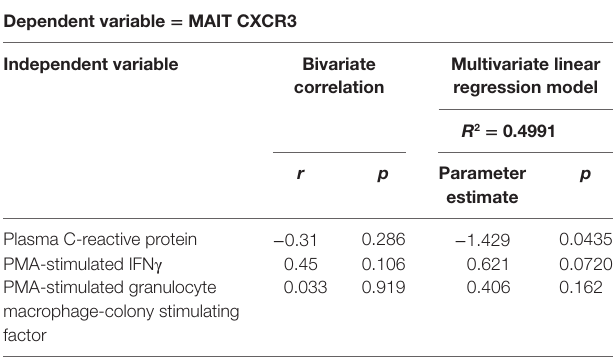
TaBle 2 | Multivariate linear regression modeling of ex vivo mucosal-associated invariant T (MAIT) cell CXCR3 expression. Dependent variable = MaiT